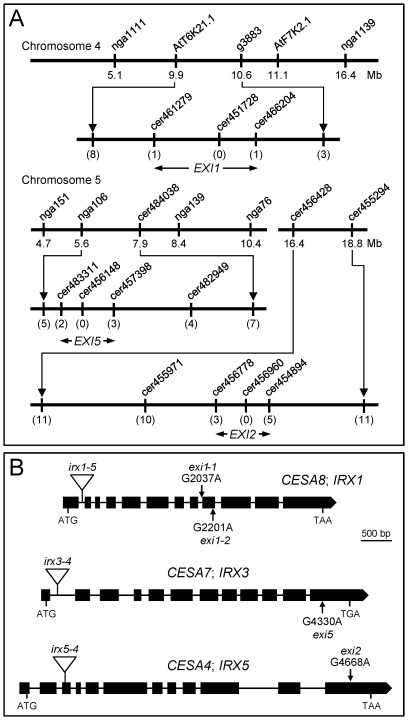
Positional cloning of the EXI1, EXI2 and EXI5 genes.(A) Map-based cloning strategy used to identify the EXI genes. Mapping populations of 217 F2 plants were derived from an exi1-1×Col-0 cross, 417 from an exi2×Col-0 cross, and 278 from an exi5×Col-0 cross. The candidate intervals for EXI1, EXI2 and EXI5 were of 231, 233 and 390 kb, respectively, which encompassed 70, 55 and 110 annotated genes. The molecular markers used for linkage analysis, their map positions and the number of informative recombinants identified (in parentheses) are indicated. (B) Structure of the EXI1, EXI2 and EXI5 genes, with indication of the nucleotide position (relative to the translation start site) and nature of the mutations found; a triangle indicates a T-DNA insertion. Exons are represented as boxes, and introns by lines connecting boxes. The translation start (ATG) and stop (TAA or TGA) codons are also indicated.